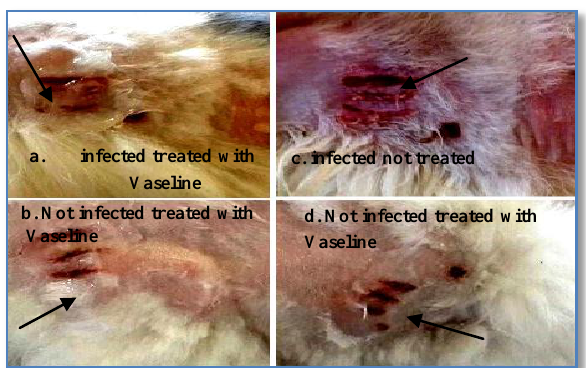
Figure, 3: Day 14 treated with Vaseline. a. (Black arrow) scar formation with highly inflammatory reaction. b. (Black arrow) scar formation with slight redness of skin. c. (Black arrow) highly inflammatory reaction with scar formation. d. (Black arrow) scar formation with slight redness of skin.